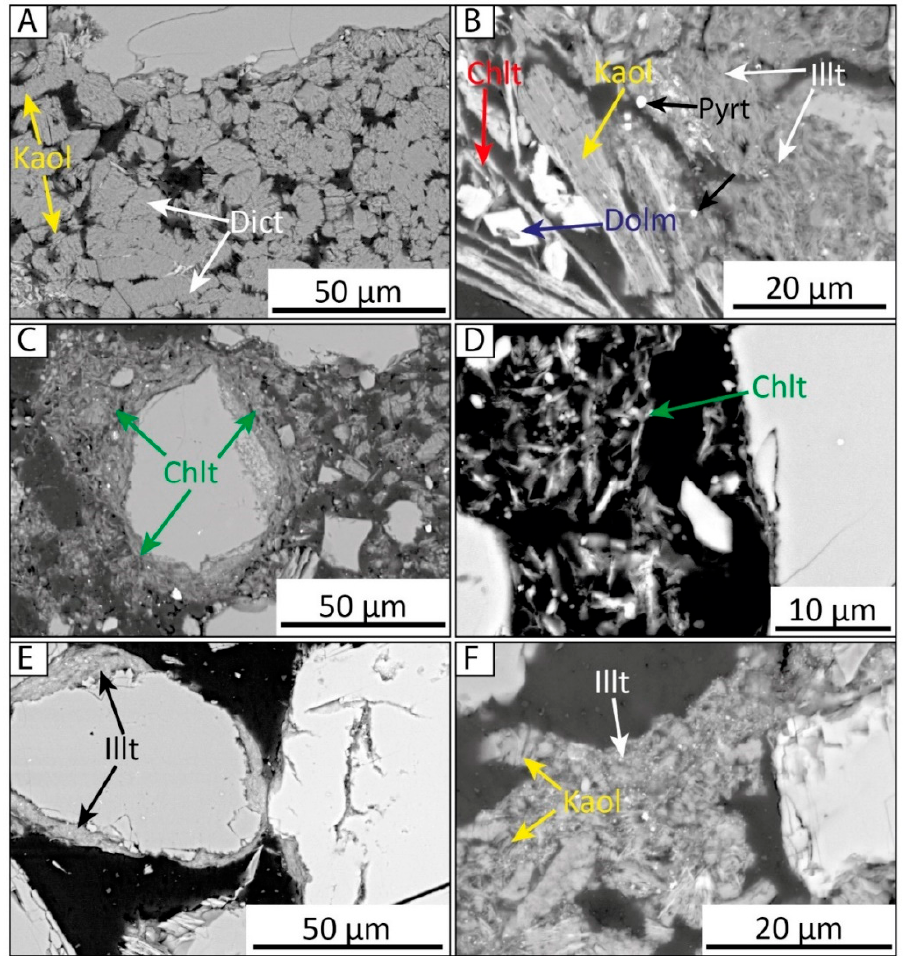
Figure 7. BSE images of the Forties Sandstone Member depicting clay types and mode of occurrence. ( A ). Pore-filling kaolinite (Kaol) transforming into blocky, higher-temperature polymorph (dickite; Dict). ( B ) Fibrous, pore-filling illite destroying intergranular porosity. ( C ) Formation of thick grain-coating chlorite and its transformation into pore-filling chlorite. ( D ) Pore-filling chlorite reducing intergranular porosity. ( E ) Grain-coating illite preventing the formation of quartz overgrowths. ( F ) Pore-filling illite replacing kaolinite and destroying RQ by pore bridging and occlusion. [BSE = Backscattered Electron].